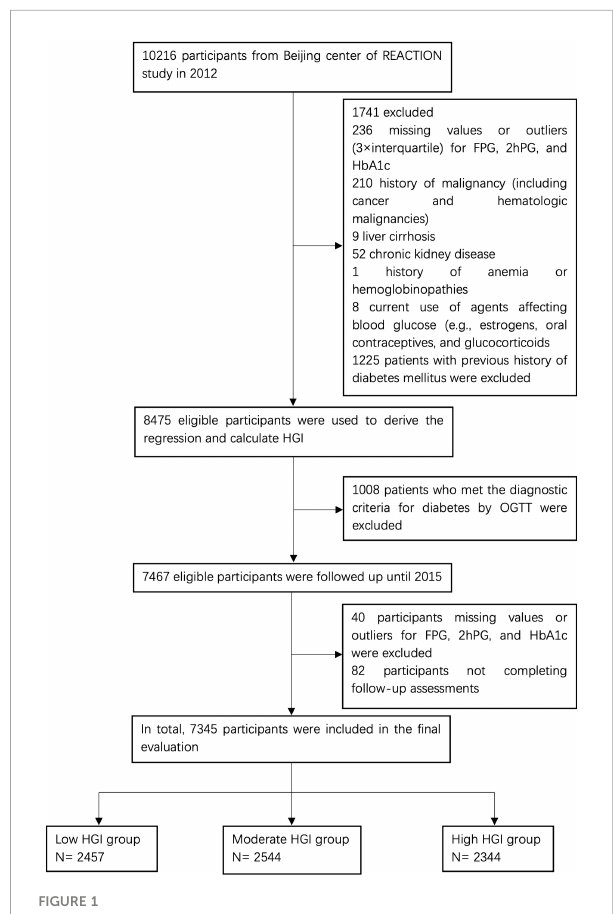
FIGURE 1 Study fl owchart of participants. FPG, fasting plasma glucose; 2hPG, 2-h plasma glucose; HbA1c, hemoglobin A1c; HGI, hemoglobin glycation index; OGTT, oral glucose tolerance